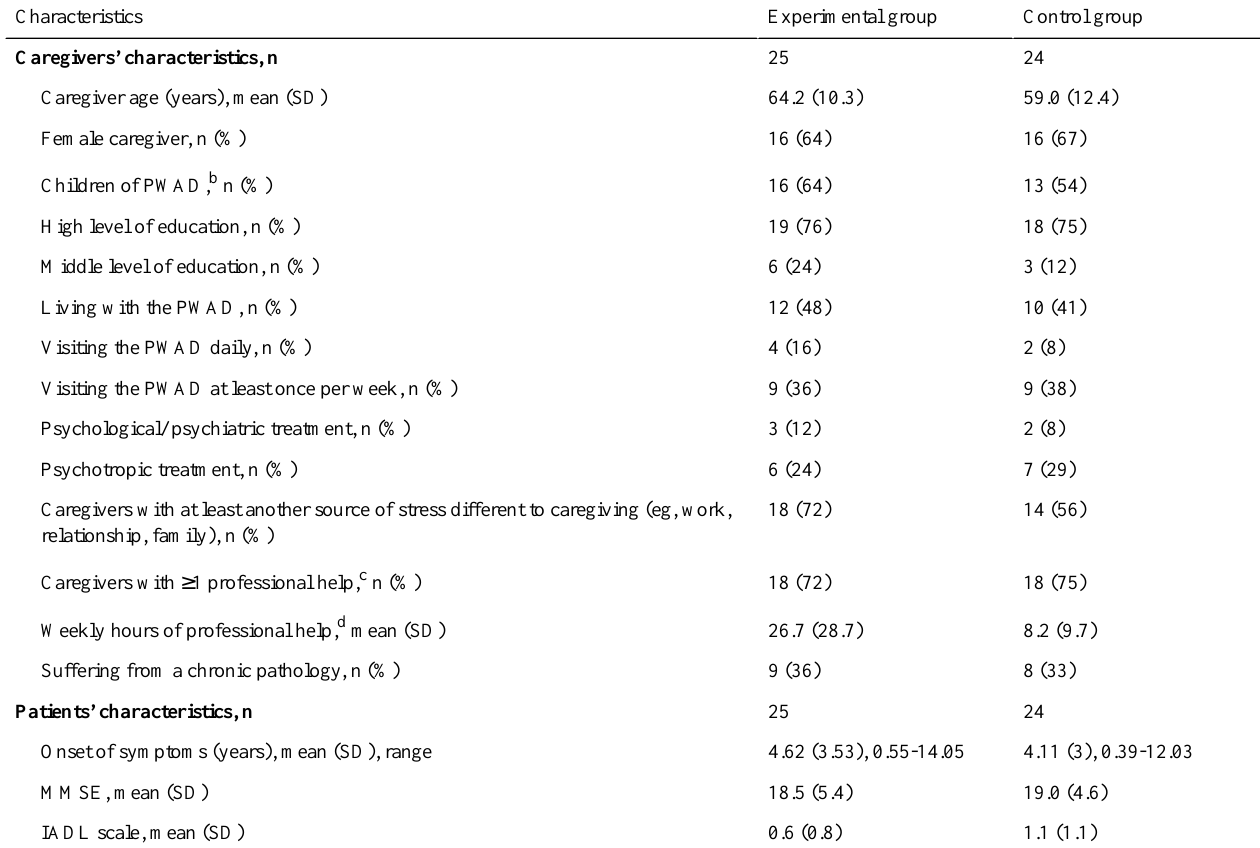
Table 1. Demographics and key characteristics at baseline by group (N=49).